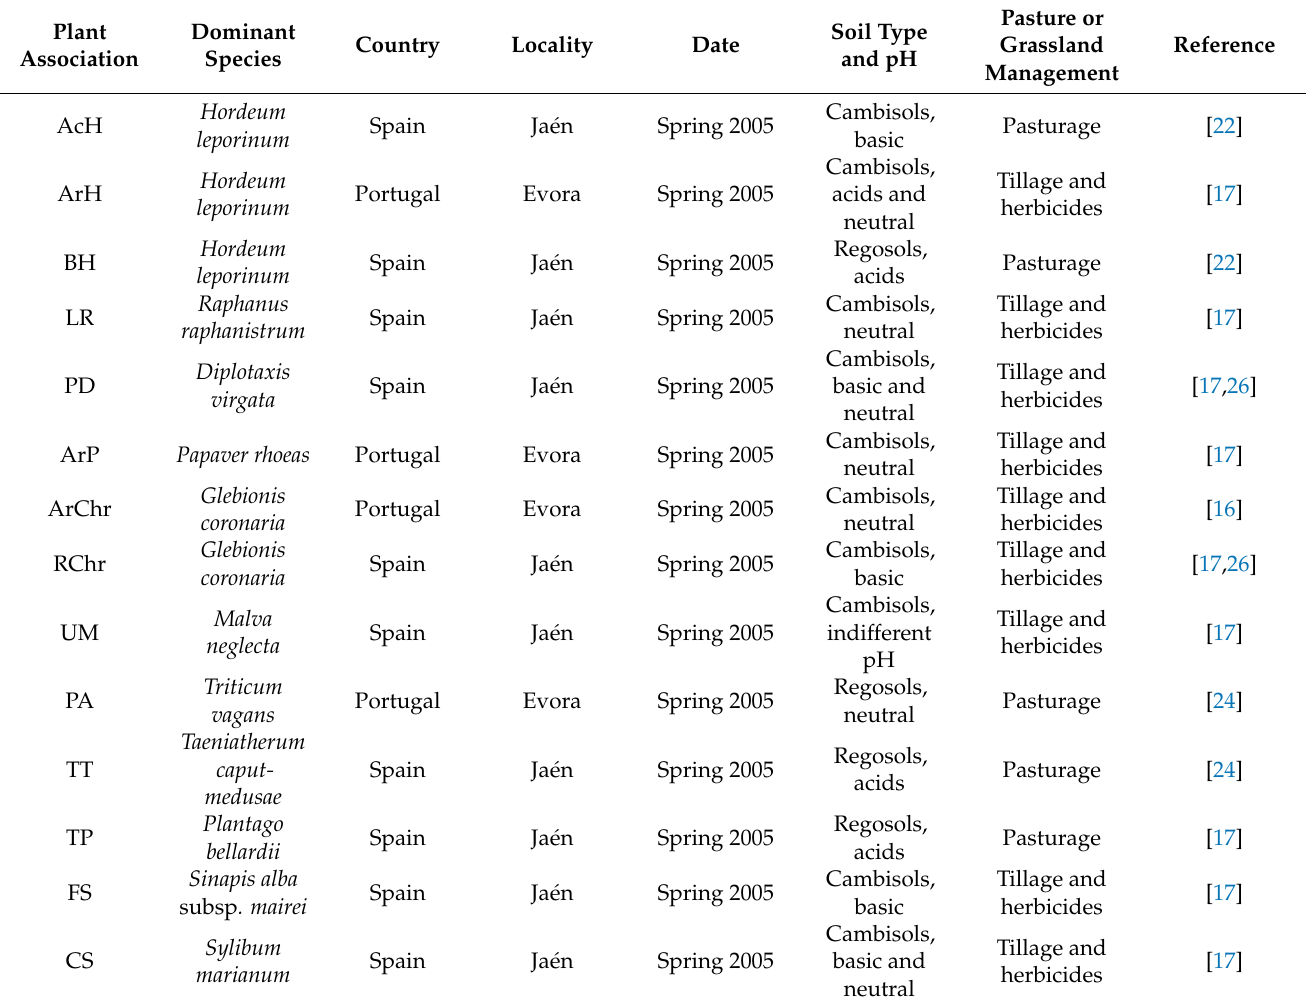
Table 1. Dominant species, countries, localities, dates of sampling, soil type and pH, pasture or grassland management, and references of the plant associations